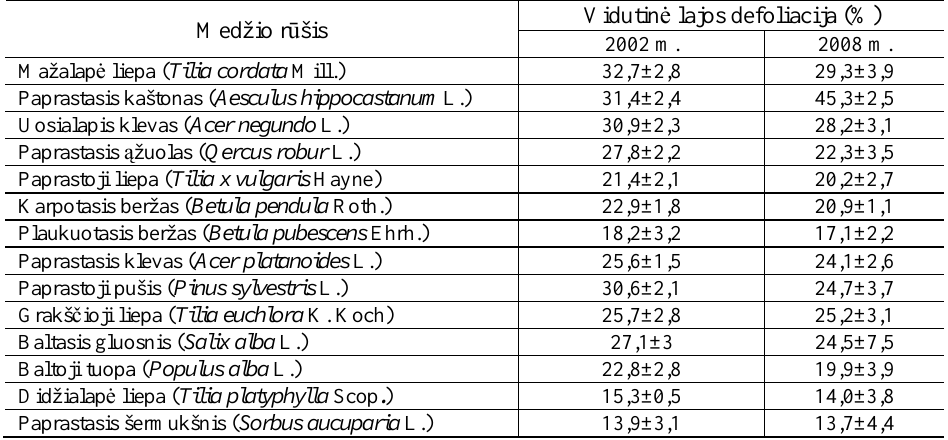
Table 2. Average foliage dechromation values of different sampled tree species in 2002 and 2008 Vidutin ė lapijos/spygli ų dechromacija (%) Medžio r ū šis 2002 m. 2008 m. Paprastasis kaštonas ( Aesculus hippocastanum L.) 12,3±2,1 14,0±0,8 Uosialapis klevas ( Acer negundo L.) 14,2±1,8 11,8±1,9 Paprastoji liepa ( Tilia x vulgaris Hayne) 11,2±2,0 10,5±1,9 Karpotasis beržas ( Betula pendula Roth.) 11,8±2,0 11,2±0,6 Plaukuotasis beržas ( Betula pubescens Ehrh.) 11,0±1,6 10,0±0,6 Paprastasis ą žuolas ( Qercus robur L.) 7,8±0,9 10,2±0,7 Mažalap ė liepa ( Tilia cordata Mill.) 13,2±2,5 11,3±0,4 Paprastasis klevas ( Acer platanoides L.) 9,8±1,8 11,3±0,6 Paprastoji pušis ( Pinus sylvestris L.) 14,9±1,8 7,9±1,9 Baltasis gluosnis ( Salix alba L.) 7,8±2,4 9,5±2,5 Grakš č ioji liepa ( Tilia euchlora K. Koch) 8,0±1,9 10,0±2,9 Didžialap ė liepa ( Tilia platyphylla Scop . ) 7,1±2,1 9,0±1,5 Paprastasis šermukšnis ( Sorbus aucuparia L.) 6,0±2,1 8,3±1,7 Baltoji tuopa ( Populus alba L.) 5,1±1,0 5,0±0,0